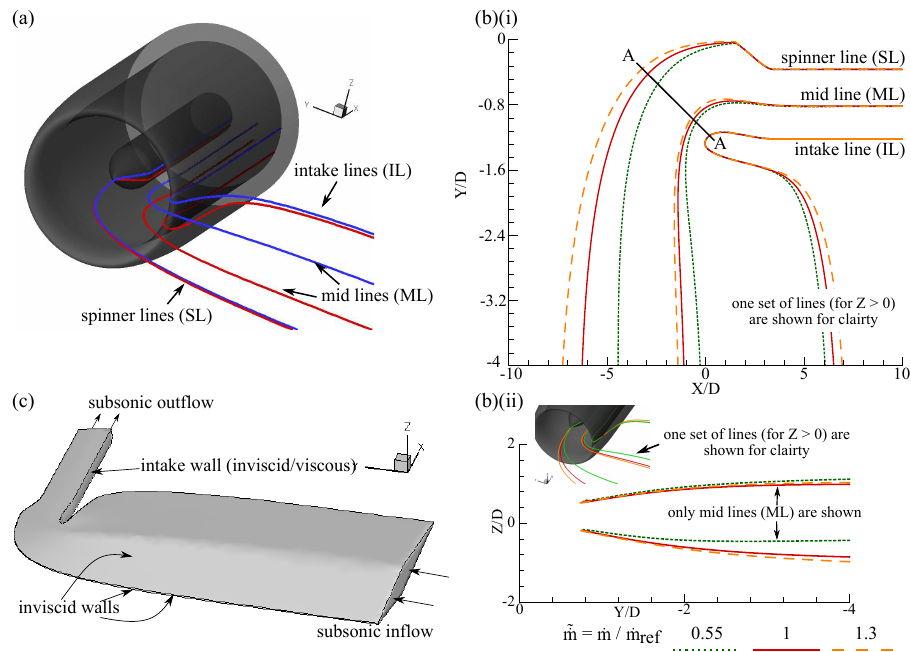
Figure 9. ( a ) Captured streamtube for (cid:101) ˙ m = 1, for F3D axisymmetric intake; ( b ) captured streamtube at different mass flow rates; ( c ) 3D view of axisymmetric quasi-3D (Q3D) duct with corresponding Boundary Conditions